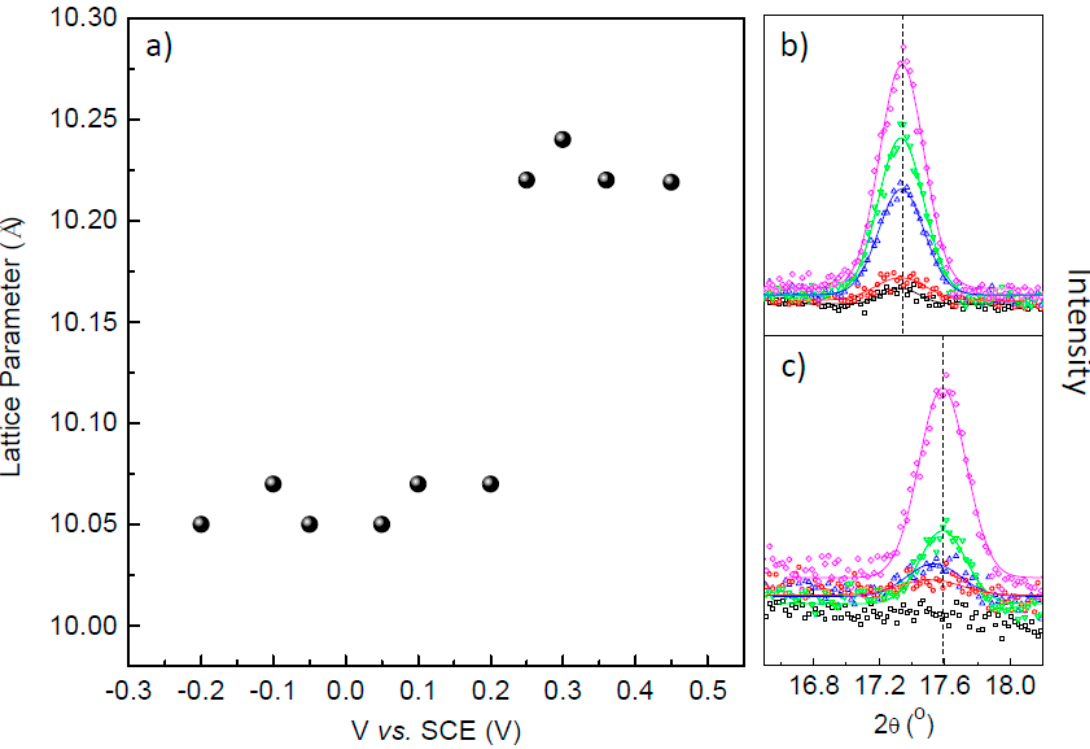
Figure 4. ( a ) The lattice parameter as a function of deposition potential. The amplified (200) peak for samples deposited at ( b ) 0.30 V and ( c ) − 0.10 V for electrodeposited charges of 10, 20, 30, 40 and 50 mC fitted with Gaussian curves.